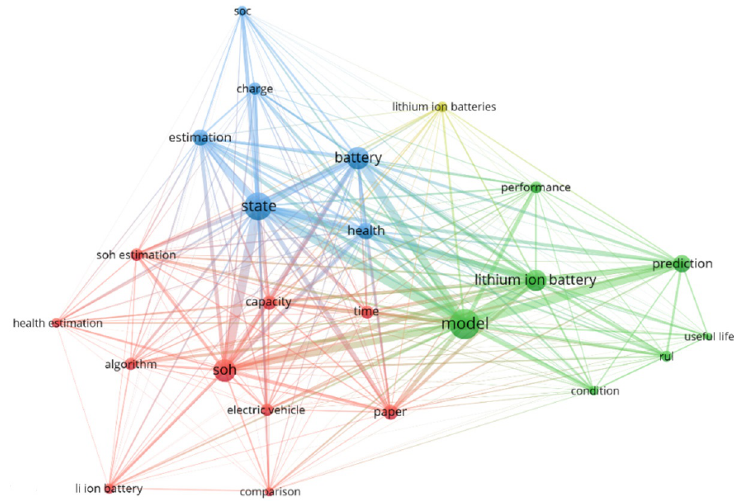
Figure 2. Title and abstract fields analysis in the literature review.